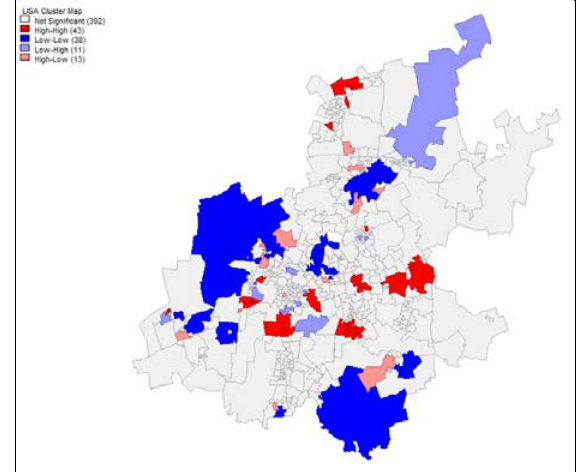
Figure 8. Cluster map of Headcount (%) in 2001